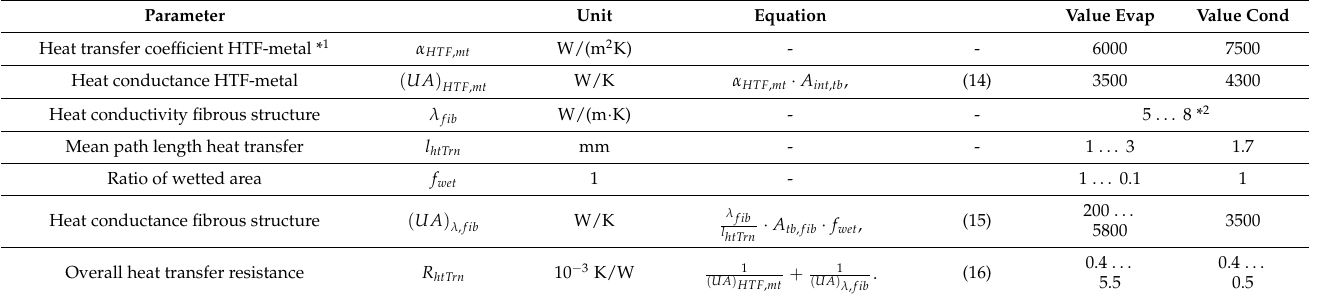
Table 5. Calculation of the overall heat transfer resistance of the evaporator-condenser. We give two sets of values—evaporation (evap) and condensation